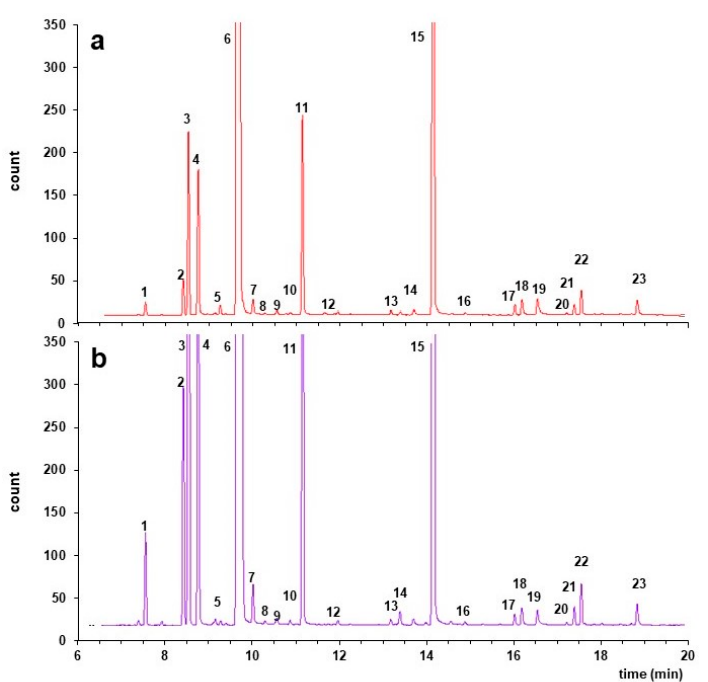
Figure 6. Total ion chromatograms of the peels collected by SPME / GC / MS. ( a ) Neapolitan limmo. ( b ) lemoncetta Locrese. Peak numbers correspond to the numbers in the first column of Table 5. In the variety lemoncetta Locrese 12 volatile compounds were in concentrations significantly higher than in limmo (Table 4). Table 4. Volatile compounds identified in the juices of the Neapolitan limmo and lemoncetta Locrese. Data were expressed as: Area volatile compound / Area Internal Standard (A / As.i.) and Area percent (%). Values correspond to average ± standard deviation. Values are significant at p < 0.05. Neapolitan Limmo Lemoncetta Locrese p -Value Peak Volatile Compounds A / A s.i. A / A